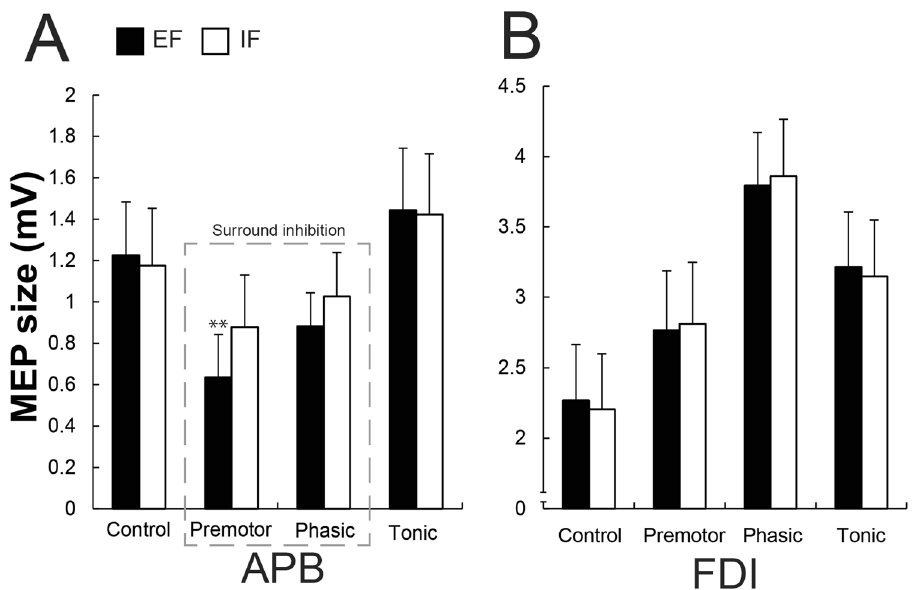
Figure 4. ( A , B ) Shown are mean values and SEM ( n = 12) of the MEP peak-to-peak amplitude in the two surrounding muscle APB ( A ) and the prime mover FDI ( B ) at four different brain stimulation time points (Control, Premotor, Phasic and Tonic) under the two attentional focus conditions (EF and IF). In the surrounding muscle APB, there was a significant interaction effect showing that when adopting a EF contrasted to an IF, surround inhibition was enhanced during the premotor phase. There was a significant main effect of phase in the prime mover FDI ( B ), reflecting its activation during the motor task. Black bars represent the external (EF) and the whites ones the internal focus of attention (IF). ** P ≤